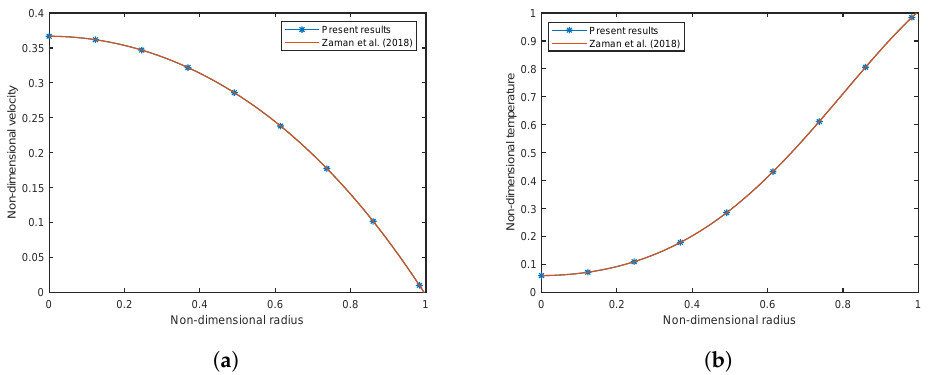
Figure 2. Comparison results ( a ) non-dimensional velocity for Gr = 0.5, ( b ) non-dimensional temper- ature for φ 2 =